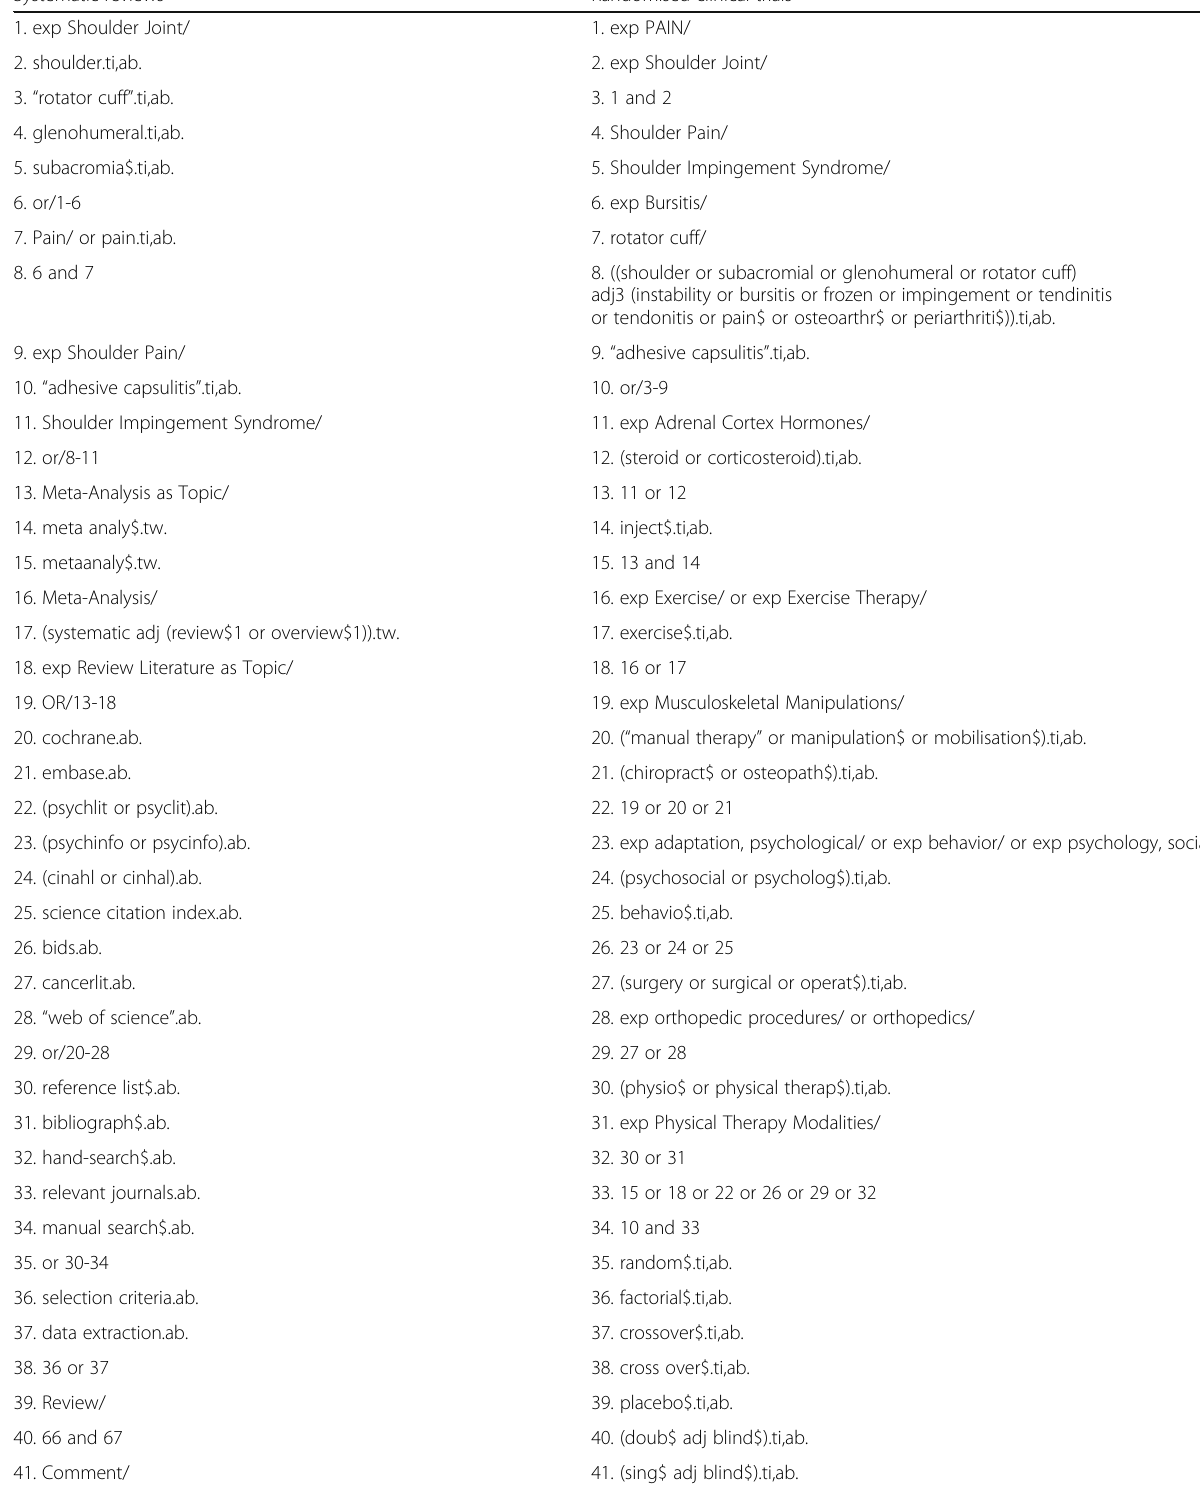
Table 2 Searches to identify systematic reviews and potentially eligible trials (MEDLINE via Ovid) Systematic reviews Randomised clinical